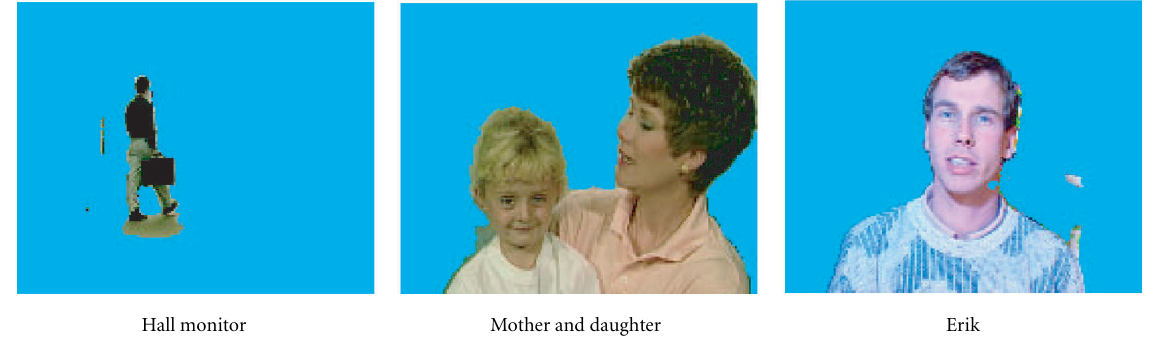
Figure 5: Change detection